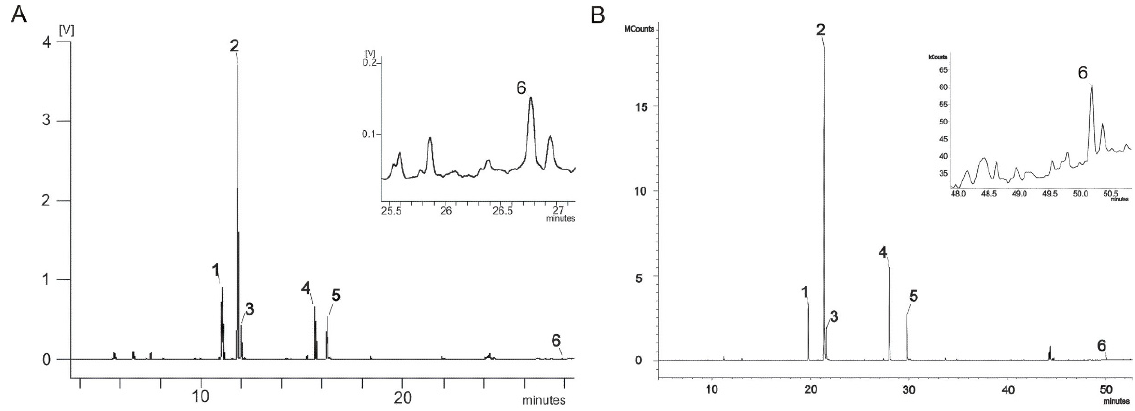
Figure 3. GC-FID (A) and GC-MS (B) chromatograms of Monarda didyma (chemotype 2) inflorescences: 1-thymoquinone, 2-thymol, 3-carvacrol, 4-butylhydroxytoluene (internal standard), 5-thymohydroquinone, and